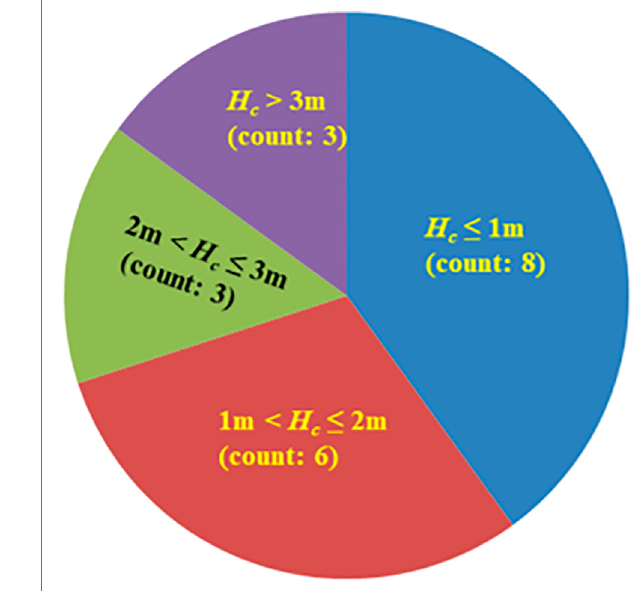
FIGURE 4 | Water gushes from the tunnelling face. FIGURE 5 | Diagram of size and counts of detected karst